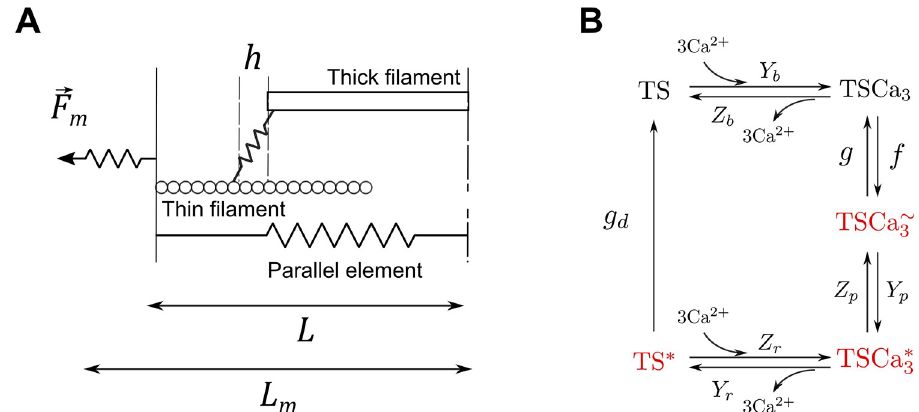
Fig 3. Half-sarcomere model. The half-sarcomere model describes the total force F element of length L (A). The crossbridges kinetic cycle is described with a 5-state model (B). The states highlighted in red correspond to attached crossbridges. Two of the rate constants, f and g d , are functions of the half-sarcomere length L (see Eqs